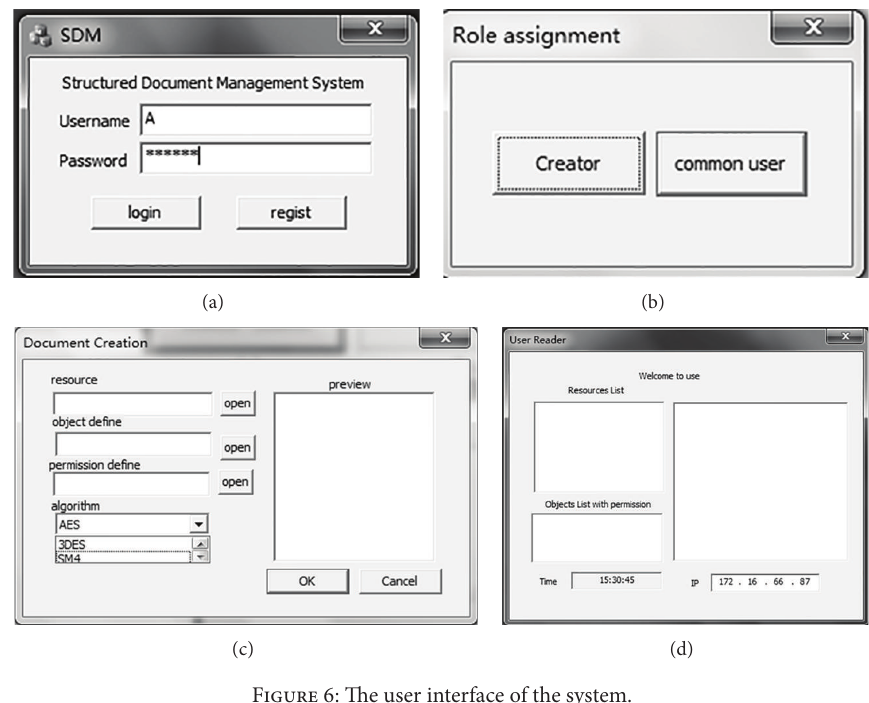
Figure 6: The user interface of the system.